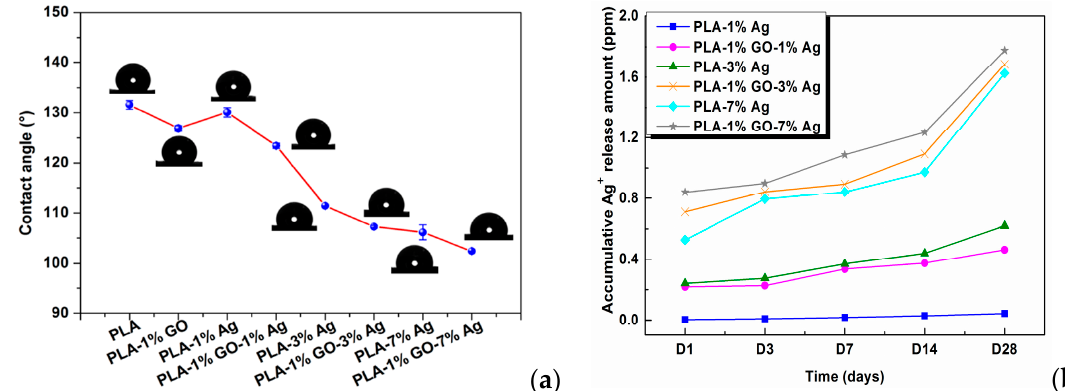
Figure 12. ( a ) Images of water contact angles on PLA and its nanocomposite fibrous mats, and ( b ) released Ag + concentration vs. immersion time profiles of PLA / AgNPs and PLA / 1 wt%GO-AgNPs mats immersed in distilled water for di ff erent time points. The concentration of silver ions was